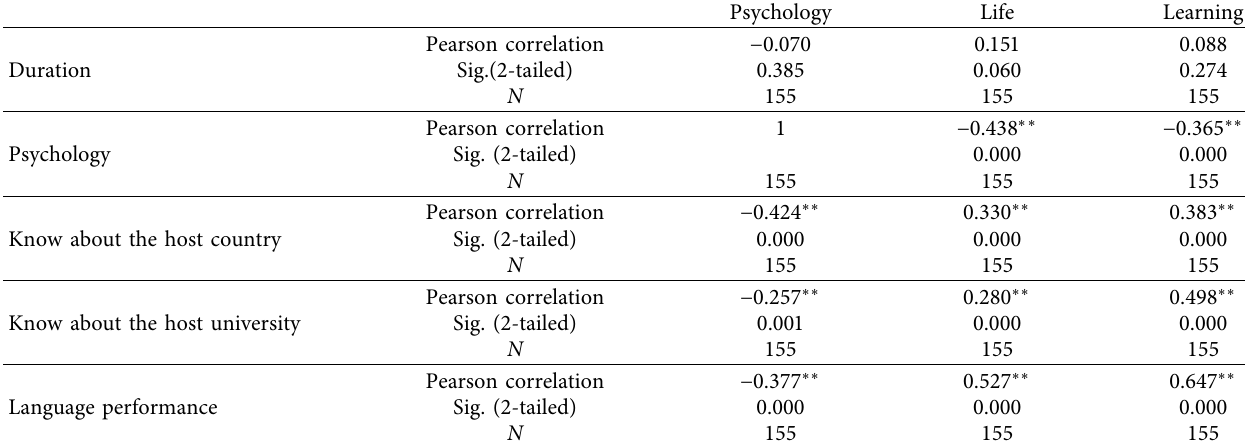
Table 5: The correlations between duration, extents SISs’ knowing about the host country and university, language performance, and SISs’ adaptation to psychology, life, and learning, respectively.